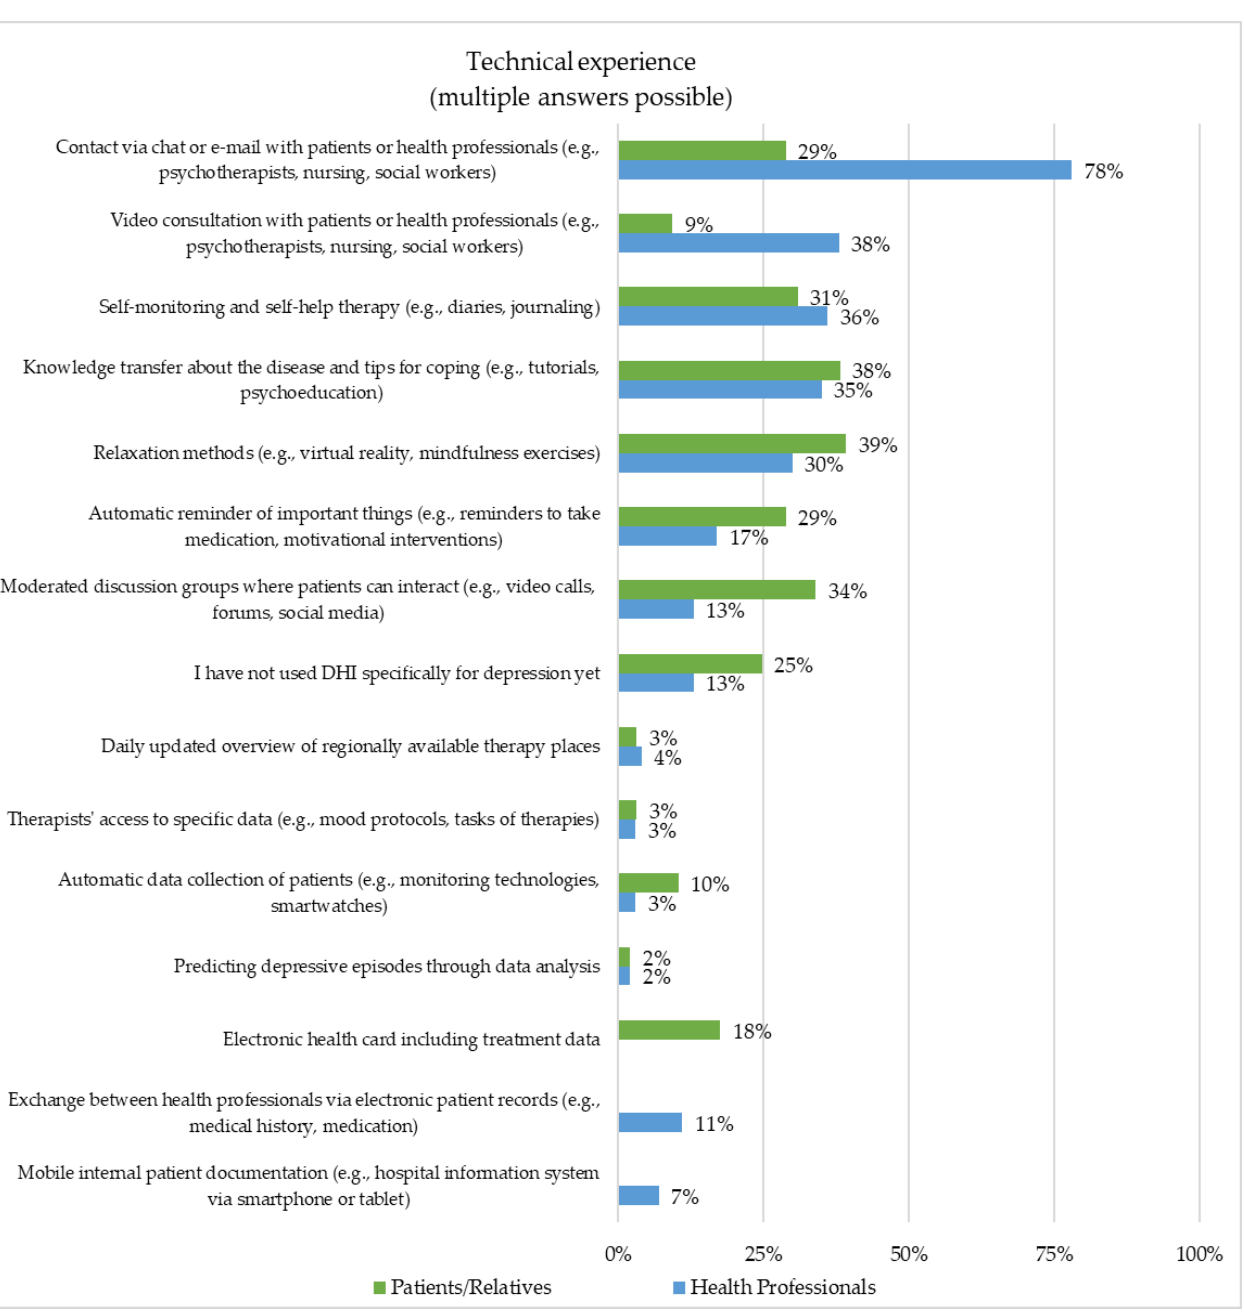
Figure 1. Representation of the technical experience (Patients/Relatives ( n = 97) and Health Profes- sionals ( n = 229)). sionals ( n =